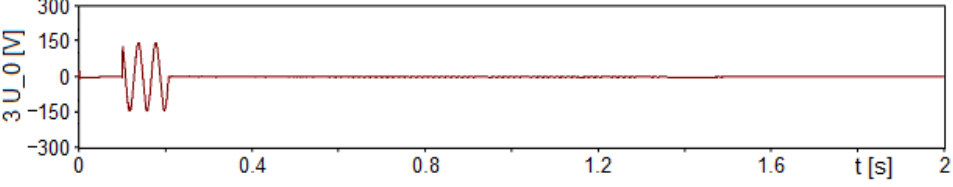
Figure 15. The voltage waveform in the open delta circuit, taking into account the presence of an earthing transformer connected to earth through a resistor R_PN = 50 Ω .